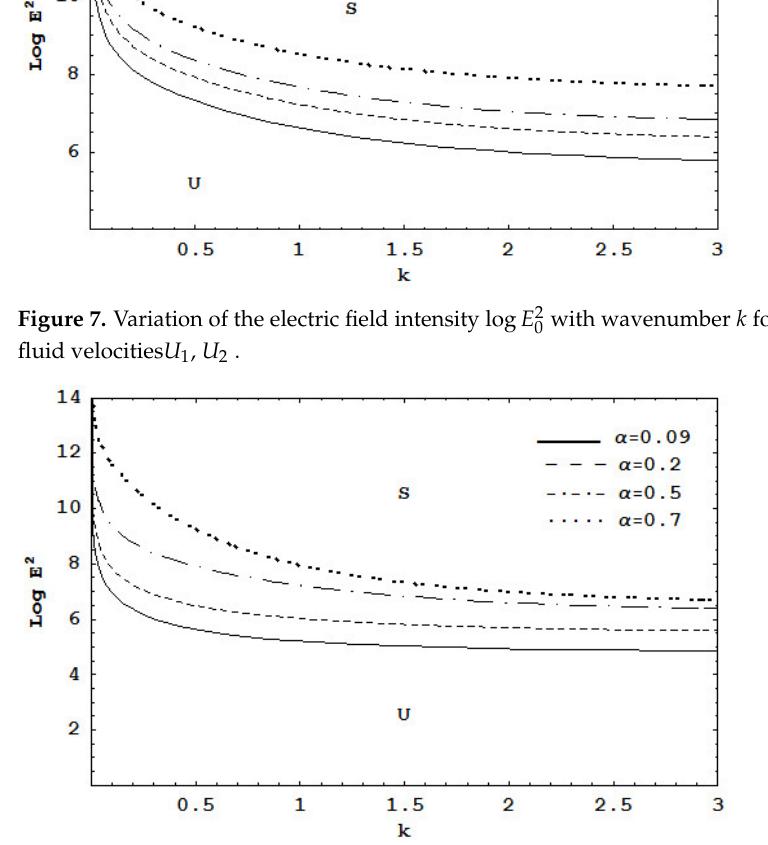
Figure 8. Variation of the electric field intensity log E 2 mass and heat transfer coefficient α